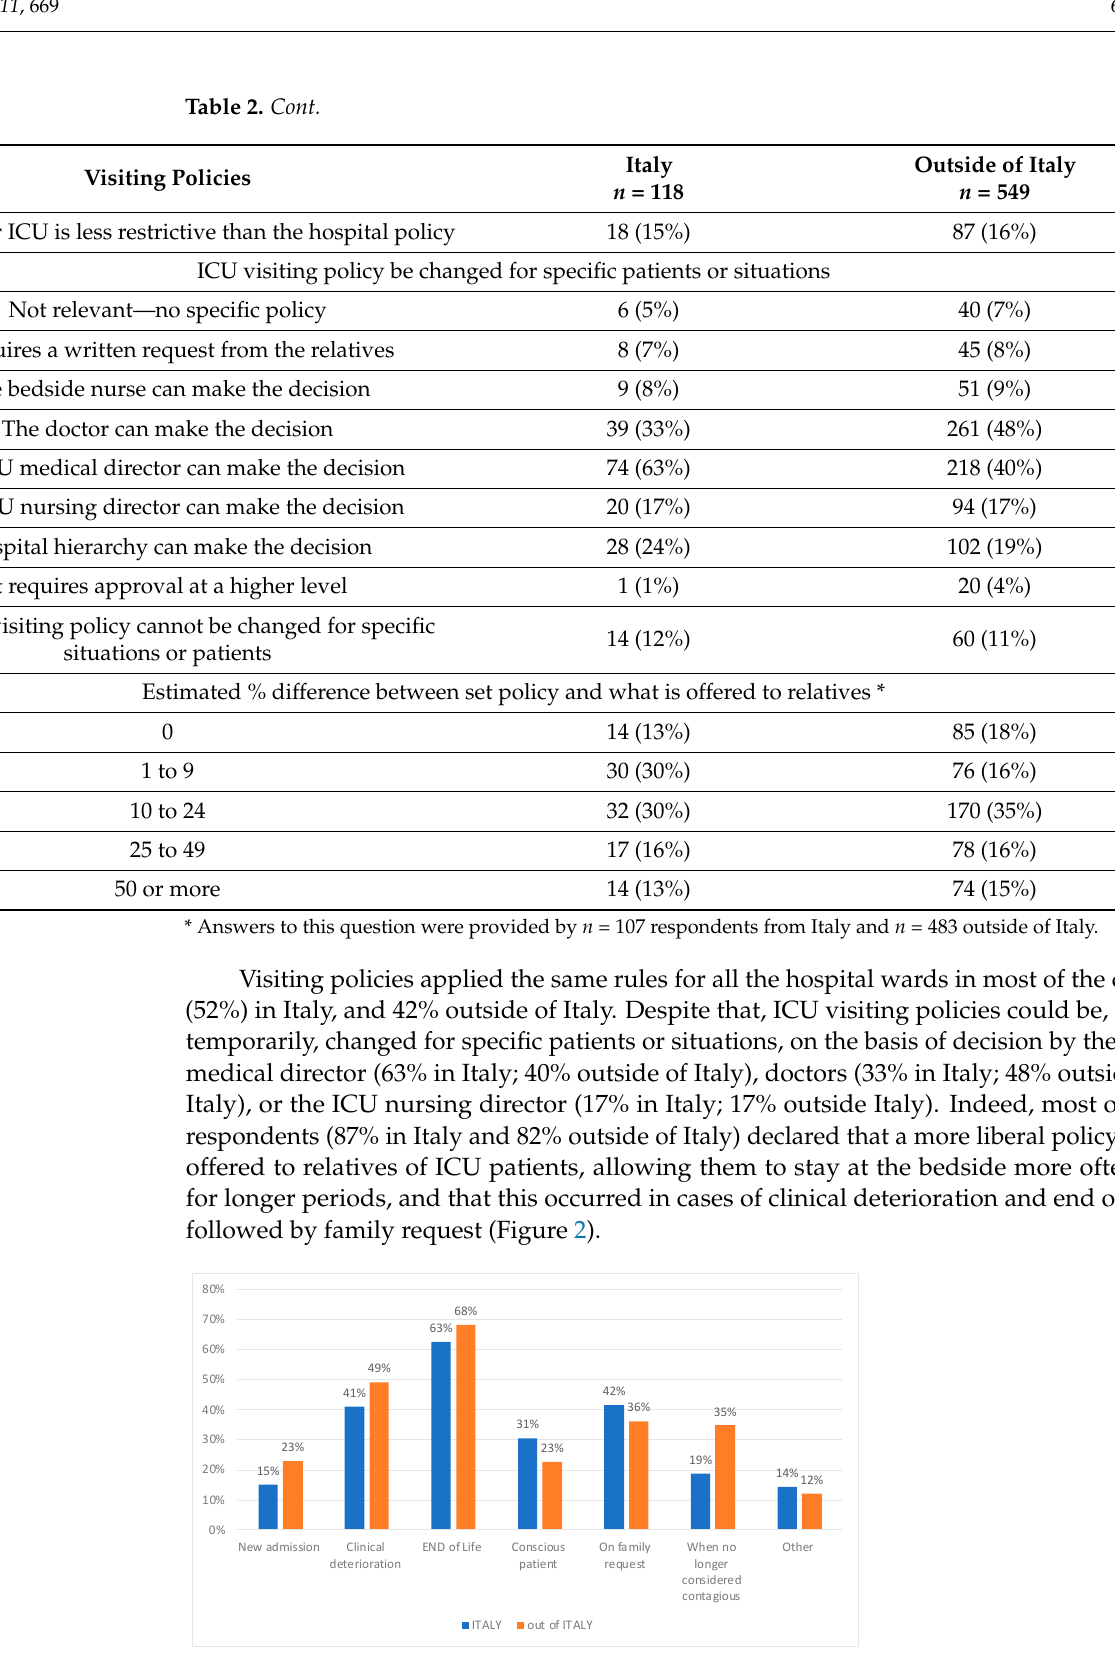
Figure 2. Reasons for allowing visiting when it would have been restricted by the set policies.